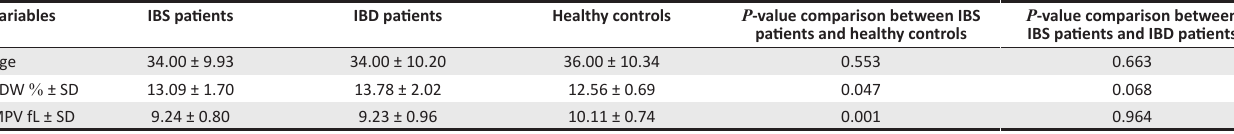
TABLE 1: Demographic and laboratory characteristics of patient and control groups, Babol, Iran, 2015–2017. Variables